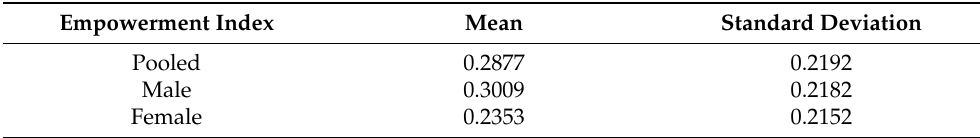
Table 6. Mean empowerment index of households by gender.